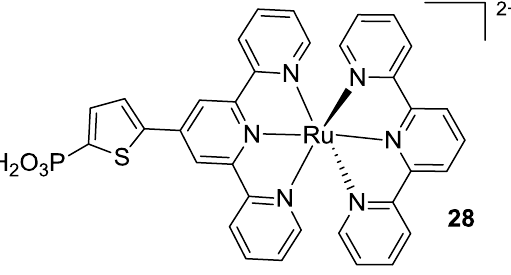
Figure 22. A structural variation of bis-py Ru complex proposed by Houarner et al. [109].